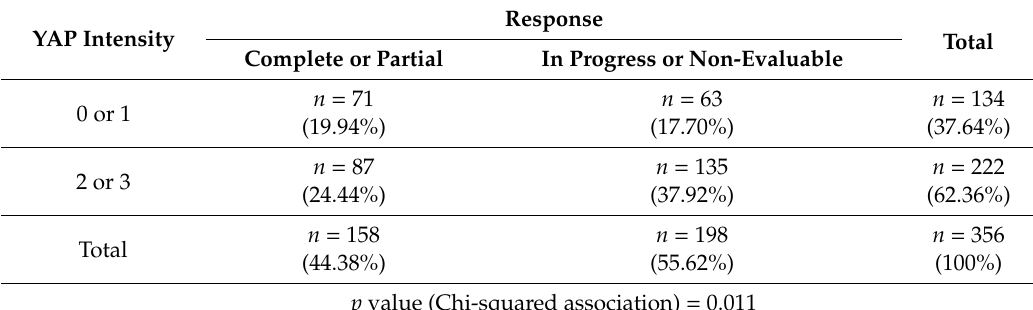
Table 1. Correlation of YAP expression with the responses to chemotherapy of 363 / 528 non-small-cell lung cancer (NSCLC) patients from the IFCT-0002